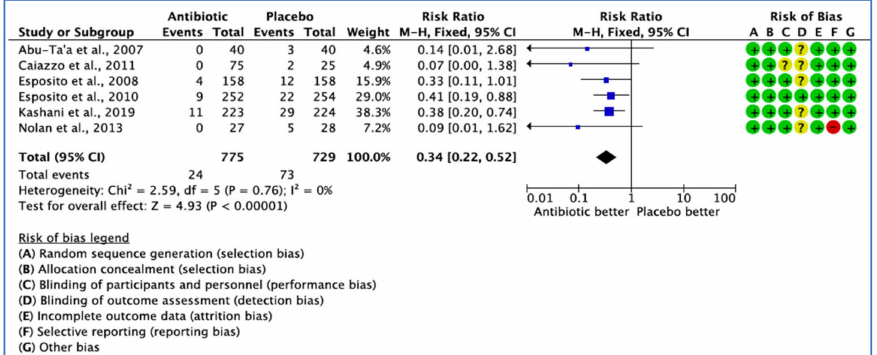
Figure 4. Forest plot of comparison between AB and placebo, which gives the summary estimate (centre of diamond) and its 95% confidence interval CI (width of diamond) based on implant failure by patients. Statistical method: Mantel-Haenszel with fixed-effect model